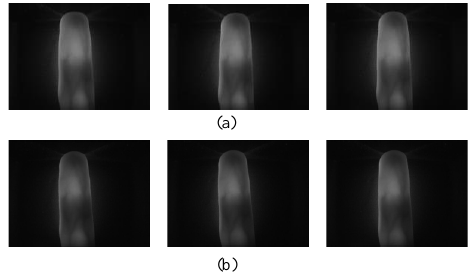
Figure 8. Finger-vein image samples collected in ( a ) first session and ( b ) second